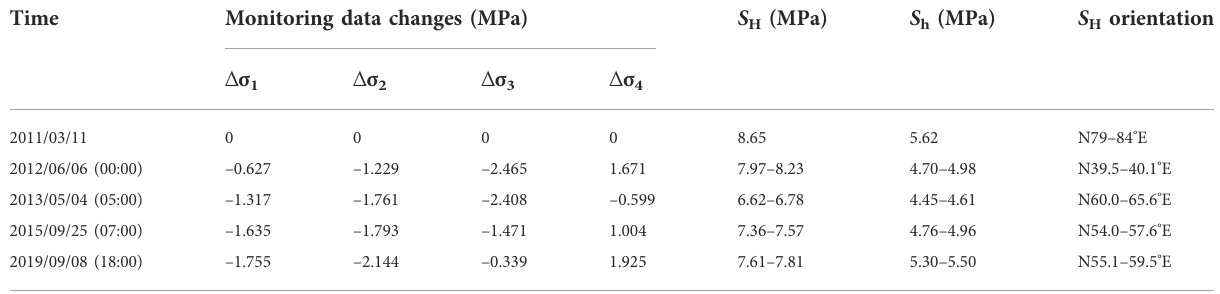
TABLE 2 Dynamic adjustment of in situ stress fi eld in Tangshan seismic region after the Tohoku-Oki 3.11 M9.0 earthquake.